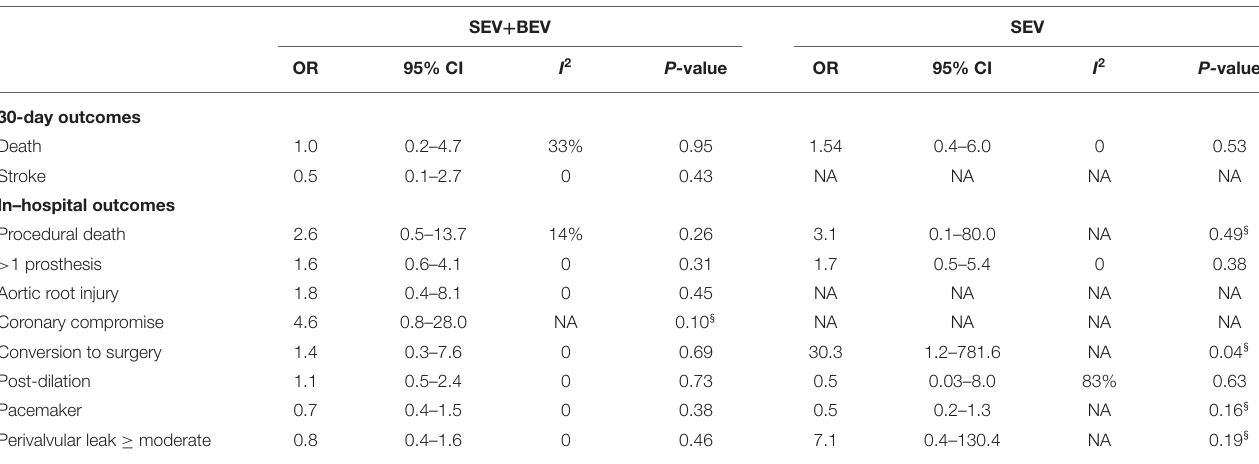
TABLE 8 | Subgroup analyses of different types of